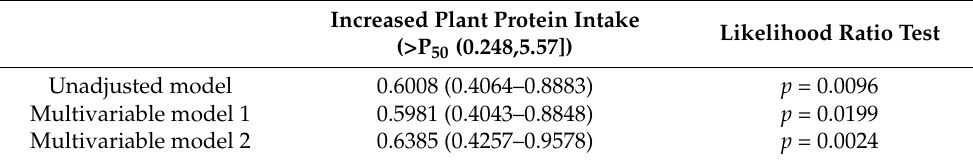
Table 3. Hazard ratios (95% confidence intervals) of T2DM incidence according to the median of Δ plant protein (%E) consumption.